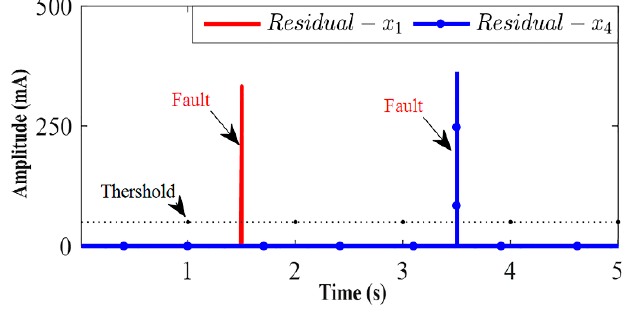
Figure 12. Residual currents of C 1 and C 4 capacitors during fault occurrence.